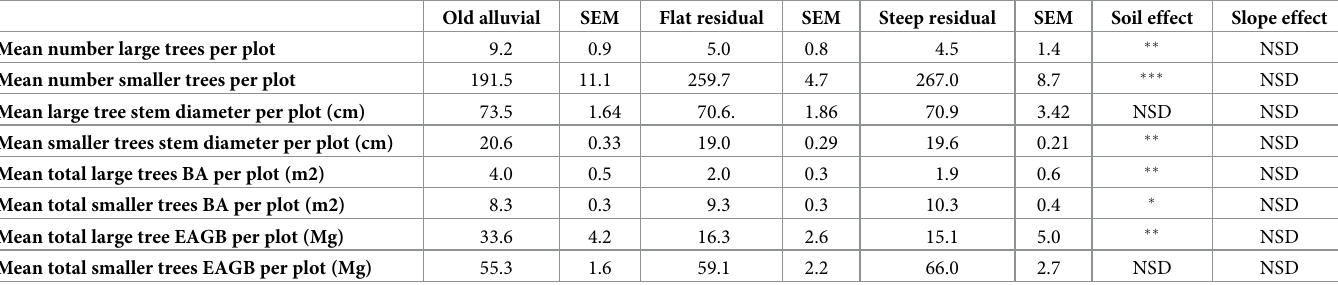
Table 5. Large tree abundance in relation to soil